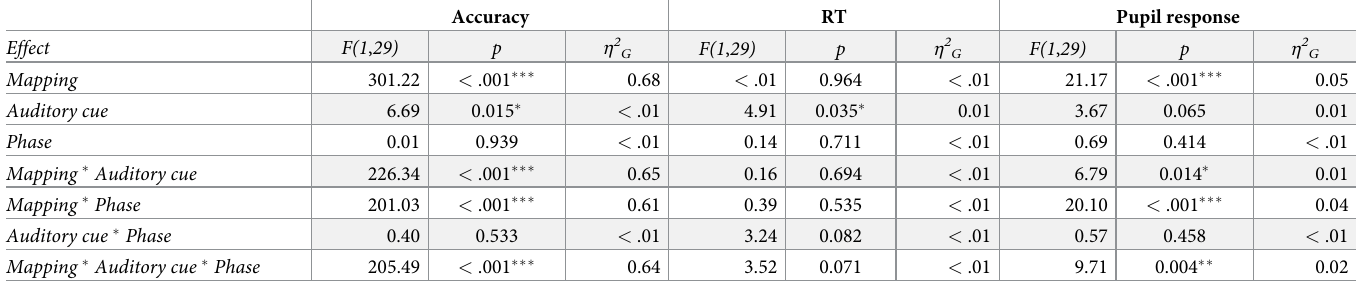
Table 1. Results of the 3-way repeated measures ANOVAs on accuracy, RT, and target-locked pupil response. Factors of interest were cue-target mapping condition (levels: M1 vs. M2), auditory cue (levels: tone vs. no tone), and task phase (levels: first vs. second). Accuracy data were percentage of correct trials; RT was analysed in sec- onds. � p < .05, �� p < .01, ��� p <